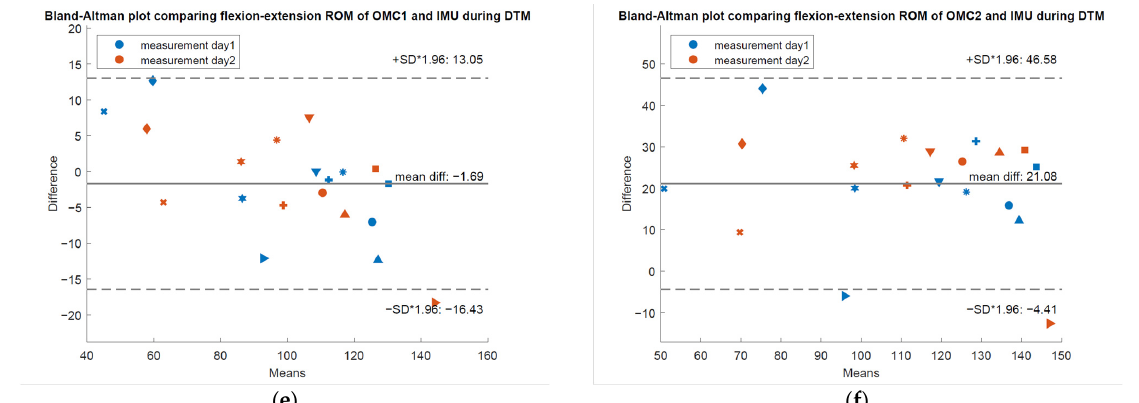
Figure A1. Bland-Altman plots showing the difference between two measurement methods for each individual trial (each trial is marked as a separate symbol) and for both measurement days in red and blue. ( a ) Comparison of OMC1 and OMC2 in radial–ulnar deviation, ( b ) comparison of OMC1 and IMU in radial–ulnar deviation, ( c ) comparison of OMC2 and IMU in radial–ulnar deviation, ( d ) comparison of OMC1 and OMC2 in flexion–extension, ( e ) comparison of OMC1 and IMU in flexion–extension, ( f ) comparison of OMC2 and IMU in flexion–extension.